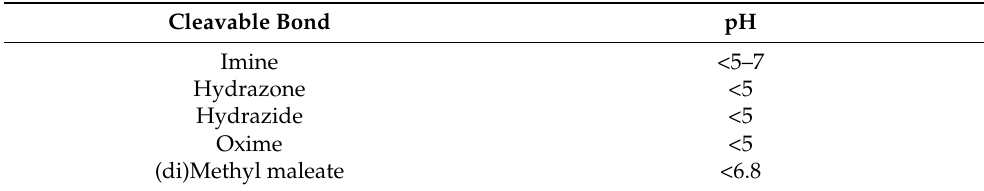
Table 2. Cleavable pH-responsive